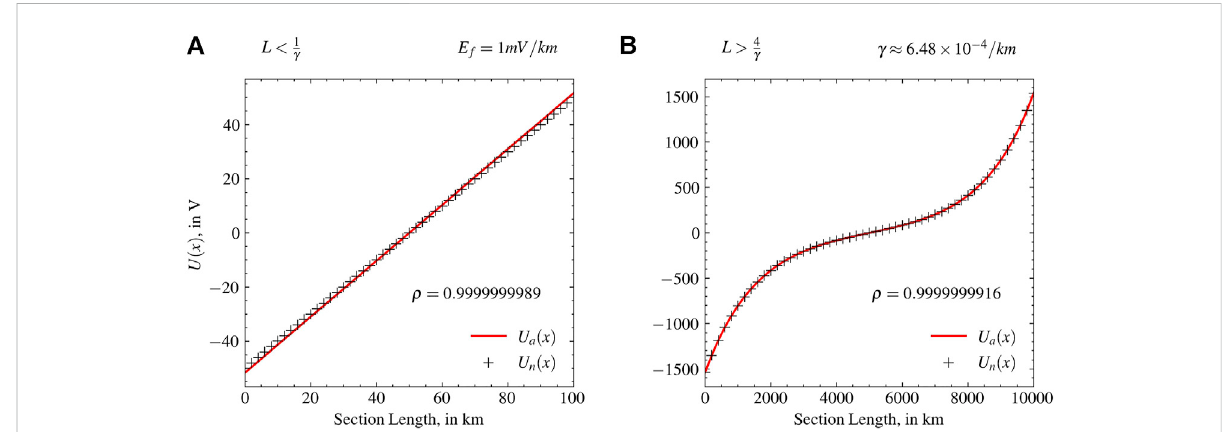
FIGURE 6 Distribution of voltage, estimated using theoretical approximation (red) and computational model (black “ + ” ), along the (A) electrically-short and (B) electrically-long Ocean-Earth sections. The correlation coef fi cient between theoretical and numerical estimates are providedin each panel. L and 1 γ are the physical length and adjustment distance of the cable, respectively. Example Python notebook for this experiment is uploaded in Zenodo